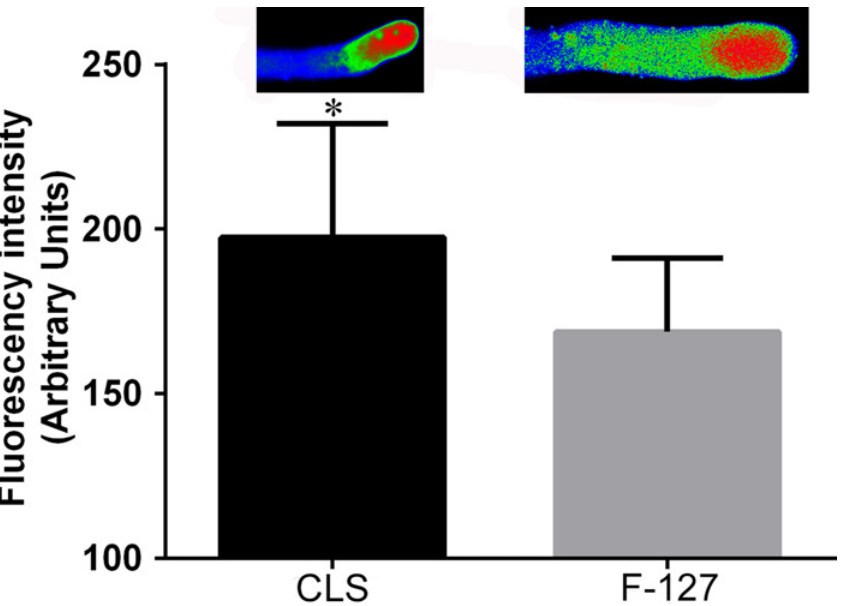
Fig 2. Comparison of the influence of the cell lysis solution and pluronic F-127 on fluo-4/AM dyeing. Fluorescence intensity using cell lysis solution as an auxiliary reagent was significantly higher ( P < 0.05, Student ’ s t-test) compared with the values obtained using pluronic F-127. Vertical bars indicate ± SE. Each data point represents the mean of three replicates with more than 10 pollen tubes each. CLS: cell lysis